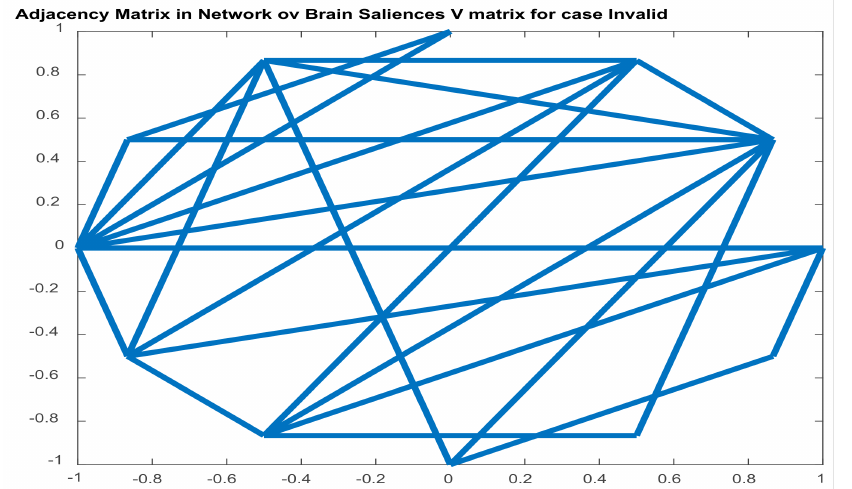
Figure 27. Adjacency matrix of the network generated by the brain salience matrix V, for the invalid syllogism. The rows and columns of V are the nodes of the network, while the links correspond to elements of the weight matrix W (normalized V and taking its elements with a threshold = 0.20). The density of the network is